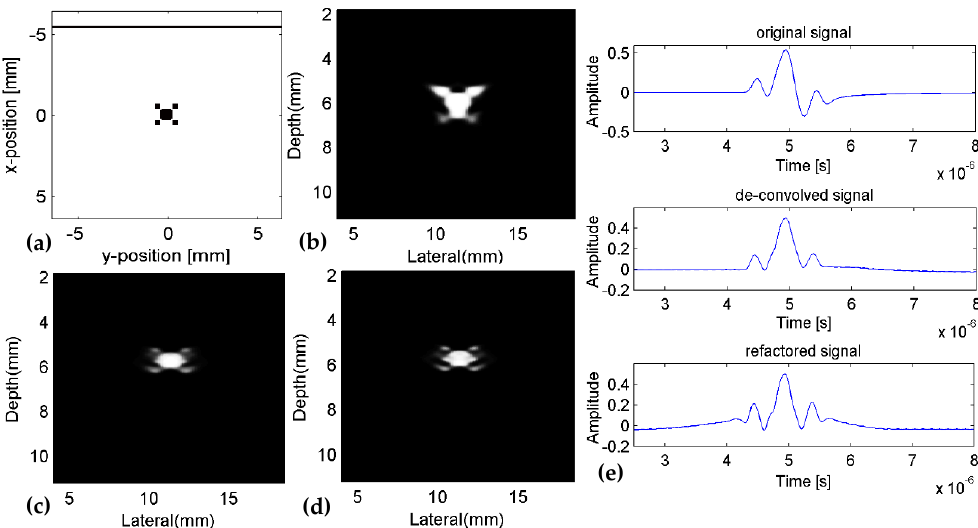
Figure 2. Results of the signal processing and reconstruction in simple numeric phantom. ( a ) the set position of source and sensors; ( b ) reconstructed image of original signal; ( c ) reconstructed image of de-convolved signal; ( d ) reconstructed image of final processed signal; ( e ) signal processing result. Appl. Sci. 2018 , 8 , x FOR PEER REVIEW